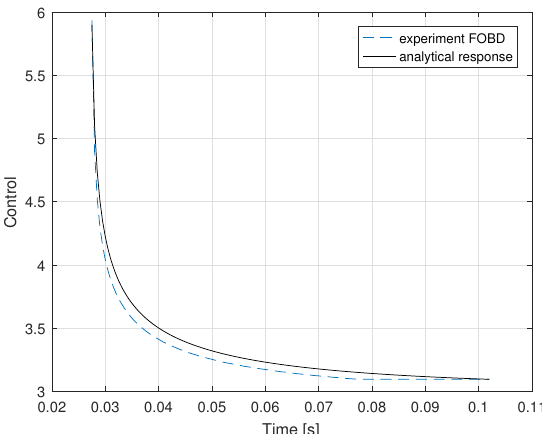
Figure 4. The step-response of FOPID using FOBD vs. the analytical response for α = 0.25, β = 0.25. IAE = 0.0114, and ISE = 0.0029.